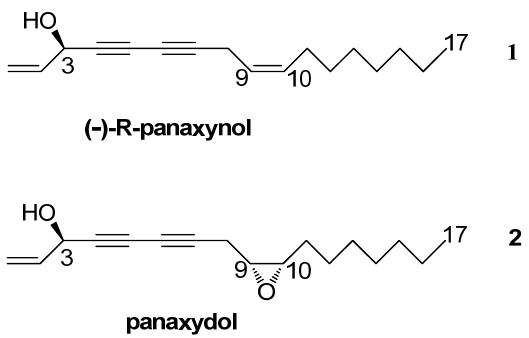
Figure 1. Structures of ( − )-( R )-panaxynol ( 1 ) and panaxydol ( 2